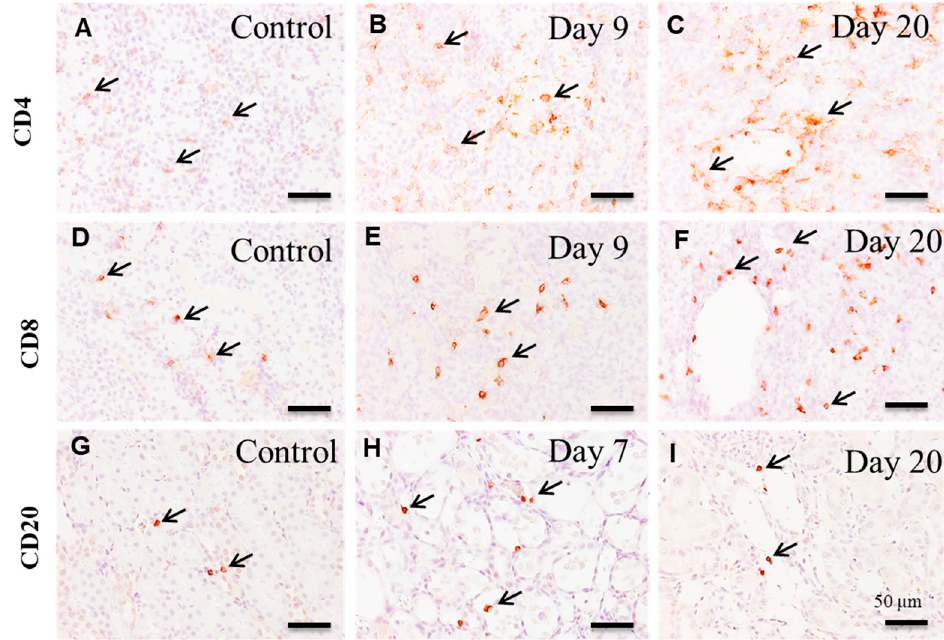
Figure 9. Immunohistochemistry for CD4 ( A – C ), CD8 (D-F) and CD20 ( G – I ) in the control and CDDP-treated kidneys. In contrast to control ( A ), the number of CD4 + T lymphocytes(arrows) are increased on day 9 ( B ) and aggregated CD4 + T cells (arrows) are seen around the affected renal tubules on day 20 ( C ). In contrast to control ( D ), CD8 + T cells (arrows) are increased on day 9 ( E ) and tend to aggregate around the affected renal tubules on day 20 ( F ). In contrast to control ( G ) and on day 20 ( I ), CD20 + B cells (arrows) are increased on day 7 ( H ). Note that the distributions of these lymphocytes are different from each other. Counterstained with hematoxylin. Bar = 50 µm.